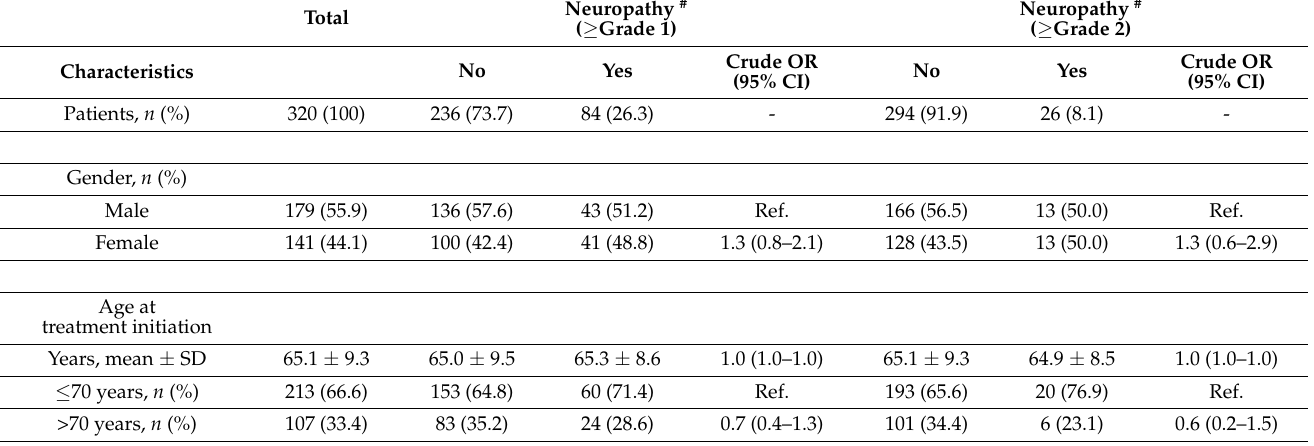
Table 1. Demographic, clinical characteristics and treatment characteristics: univariate analysis of (severe)